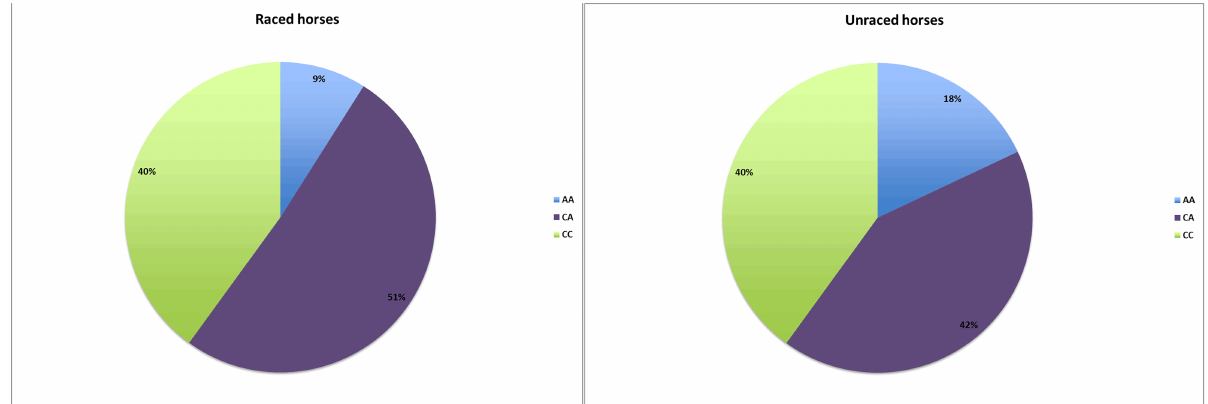
Fig 2. DMRT3 genotype frequency in raced and unraced horses.